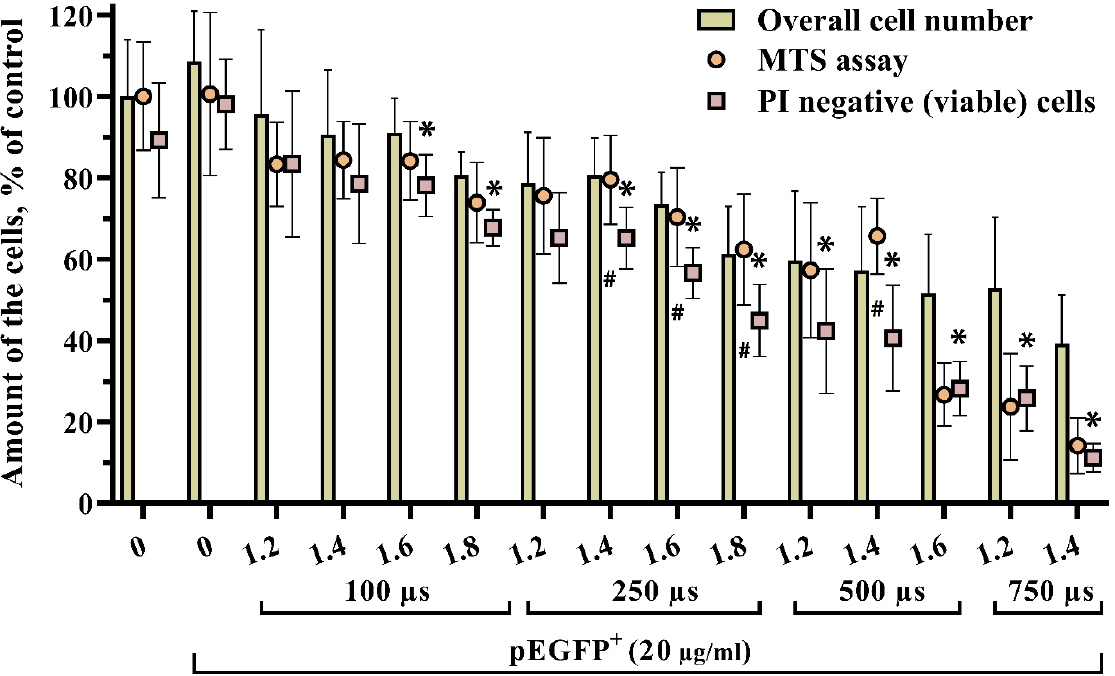
Figure 2. Viability of UT-7 cells after pEGFP gene electrotransfer using different pulse strengths and durations, evaluated by flow cytometry counting, MTS assay, and PI staining. Overall cell number represents the total number of suspension cells per sample obtained by flow cytometry. MTS stands for metabolically active cells expressed as percentage shift in metabolic activity compared to the control samples and cells with normal integrity nonpermeable plasma membrane depicted as PI negative or viable cells. The X-axis shows pulse strength in kV/cm. Error bars represent ± SD from two independent experiments performed in quadruplicate and were further analyzed using one-way ANOVA with Tukey's multiple comparisons test. Significantly different treatments at p < 0.05 are represented as * and #. The * stands for the significant difference between overall cell number and overall viable cells, while # represents a significant difference between cell metabolic activity (MTS) and overall viable cells.